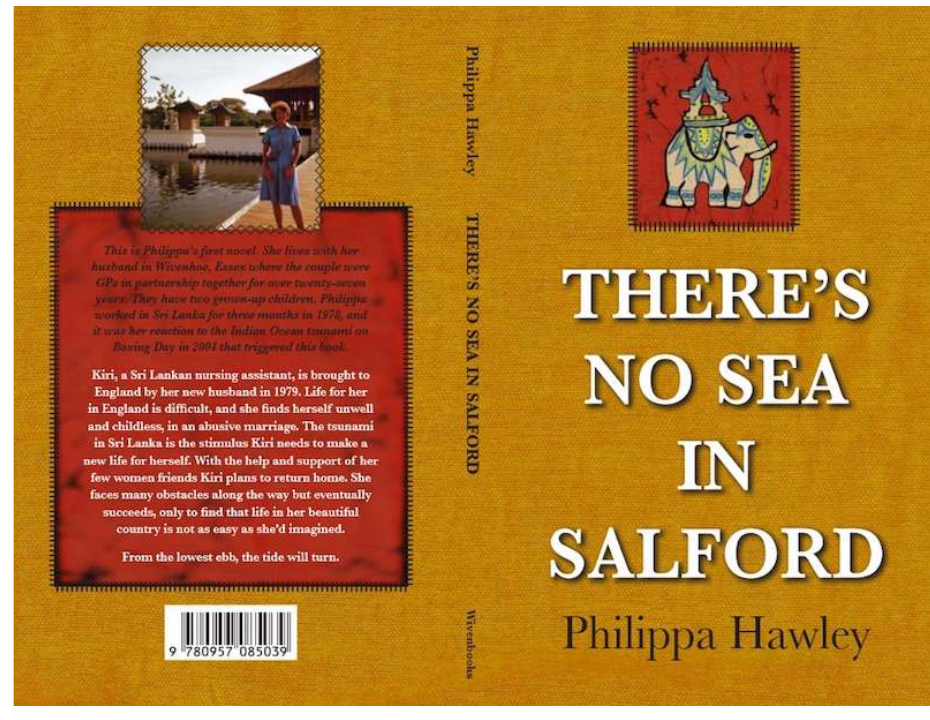
Figure 3. Cover of There’s No Sea in Salford by Philippa